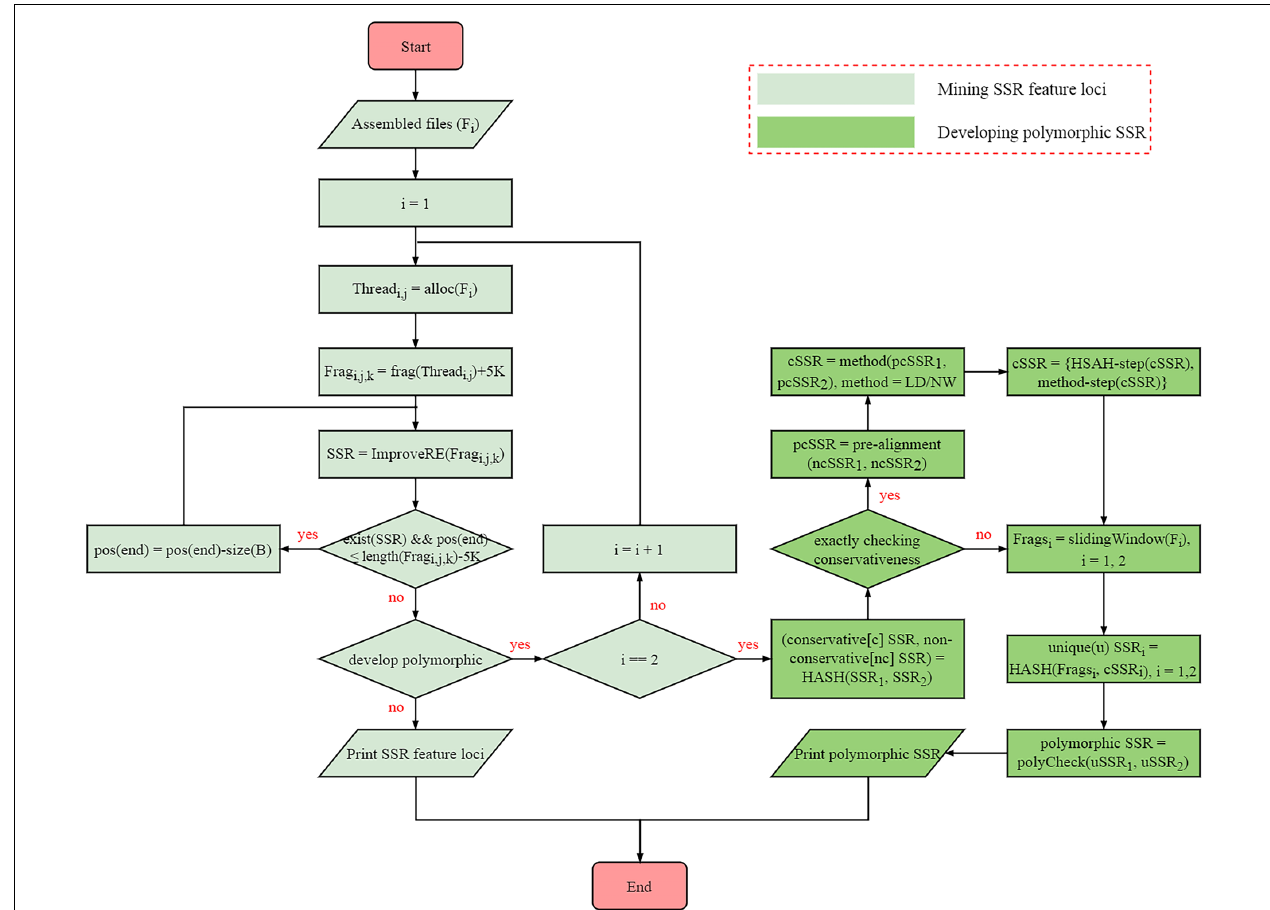
FIGURE 1 | Internal implementation algorithm of Simple Sequence Repeat Molecular Marker Developer